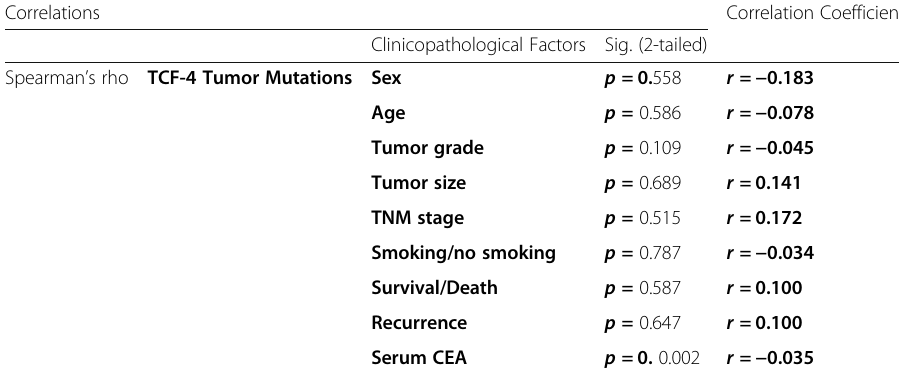
Table 5 Correlation of Clinicopathological factors with TCF-4 Tumor Mutations Correlations Correlation Coefficient